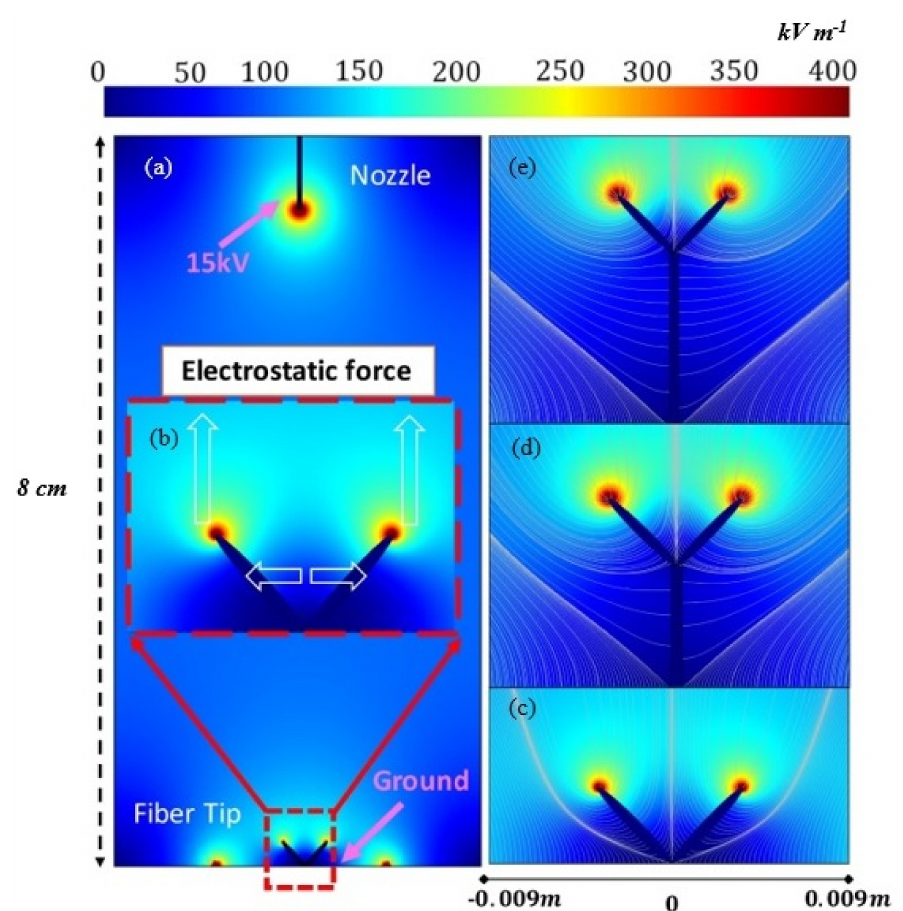
Figure 2. Electric field lines in the region between the needle and the collector. ( a and b ) Normalized electric field distribution at stage 2 of fabrication showing model configuration. The black straight line represents the charged tip of the needle. The two ‘rice’ shapes represent the two standing fiber tips attached to the grounded collecting plate. ( c–e ) Electric field lines formed near fiber tips in ( c ) stage 2 and ( d and e ) stage